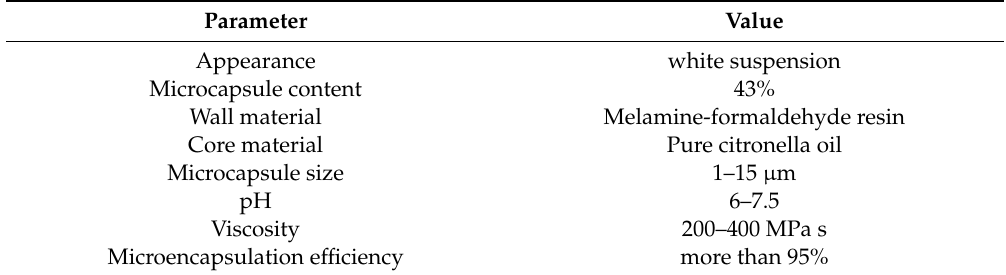
Table 6. Properties of microcapsules produced with in situ